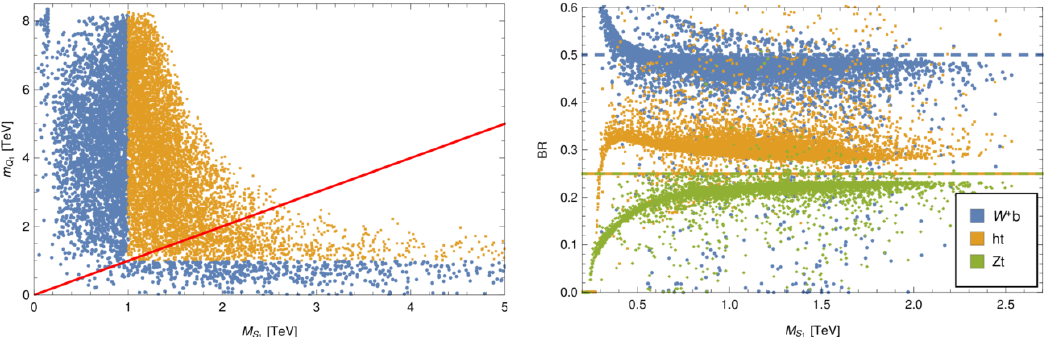
Figure 10 . Distributions in the model with two fermionic resonance layers. Left: mass of the lightest exotic top partner ( m Q ) versus the mass of the lightest singlet top partner ( M S ). For 1 1 orange (blue) points, the lightest fermionic resonance is heavier (lighter) than the approximate LHC lower bound of 1 TeV. The red line corresponds to m Q = M S . Right: branching ratios of the 1 1 lightest singlet S 1 , for the parameter points where it is the lightest fermionic resonance. The dashed lines indicate the leading order predictions, see eq.